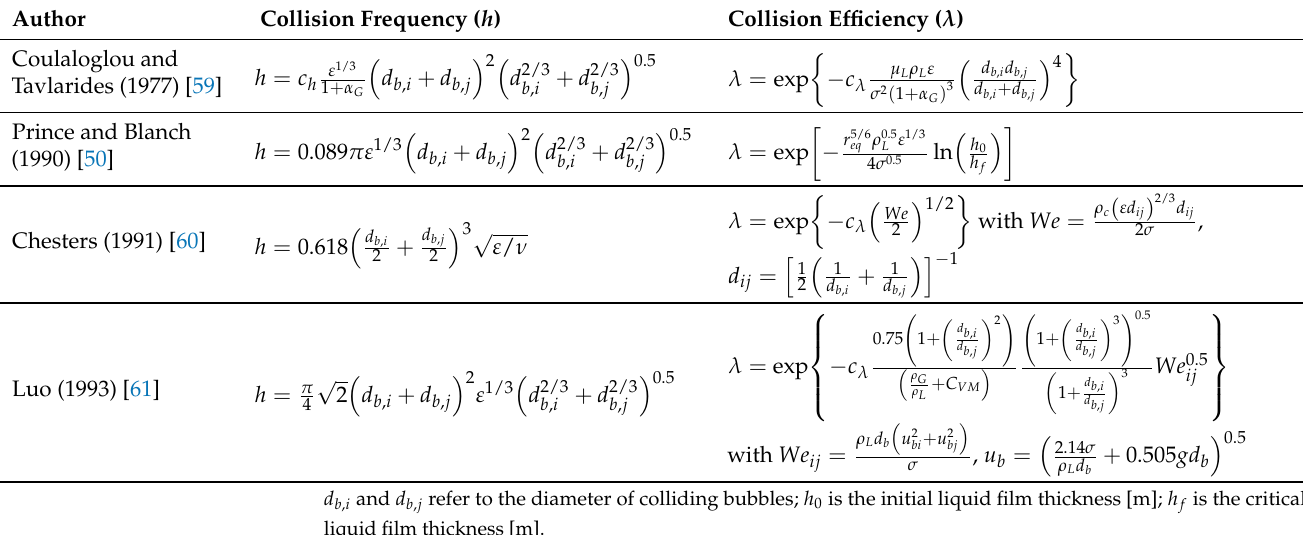
Table 3. Applicable coalescence models for bubble column